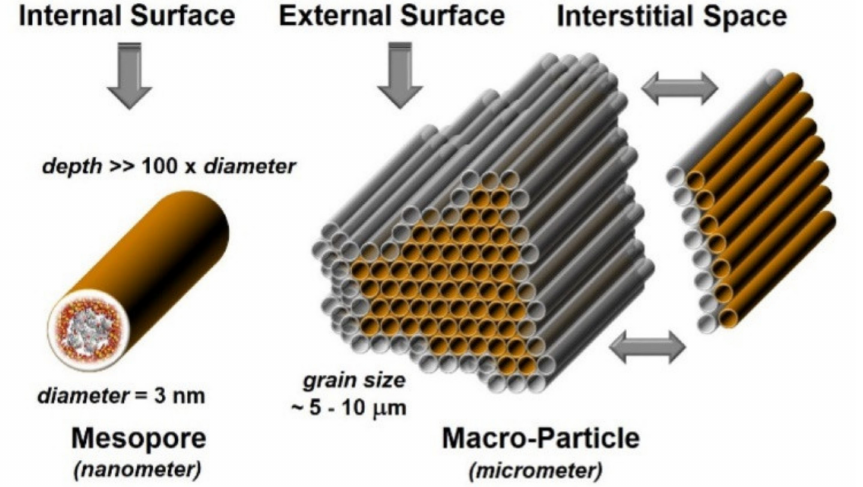
Figure 4. Illustration of internal and outer-space accessible to guest molecules in the powder samples of MCM-41 silica according to concept proposed by Torres-Barthelemy et al. [124] A single pore, with a diameter of ca. 3 nm and a depth much greater than 100 nm, give rise to a large internal volume (left). These pores are ordered in a regular honeycomb manner (middle), resulting in a non-negligible external surface (the gray area marked with the vertical arrow). The external surface gives rise to interstitial space (right) formed between the randomly ordered crystallites (see the horizontal arrows). Adapted with permission from [122], Copyright 2021 American Chemical